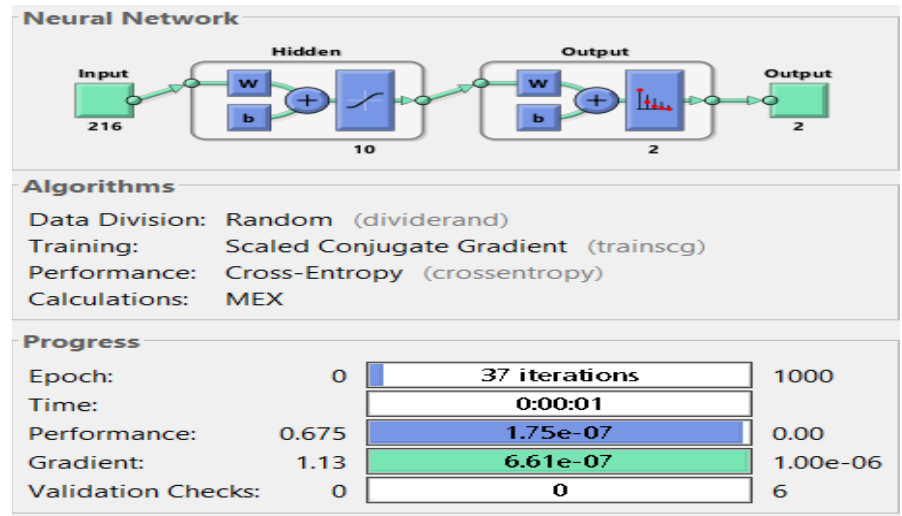
Figure 10. Training of ANN algorithm on ASD dataset.